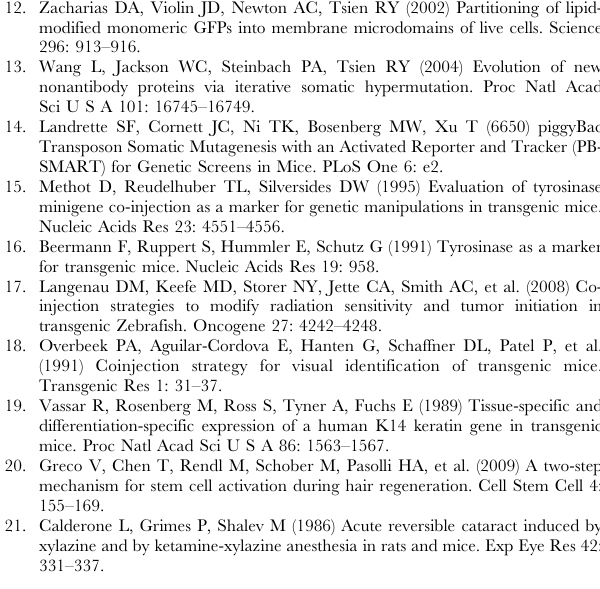
Figure S2 Expression of co-injected transgenes is not affected by fluorescent eye markers. Immunofluorescent staining of frozen skin